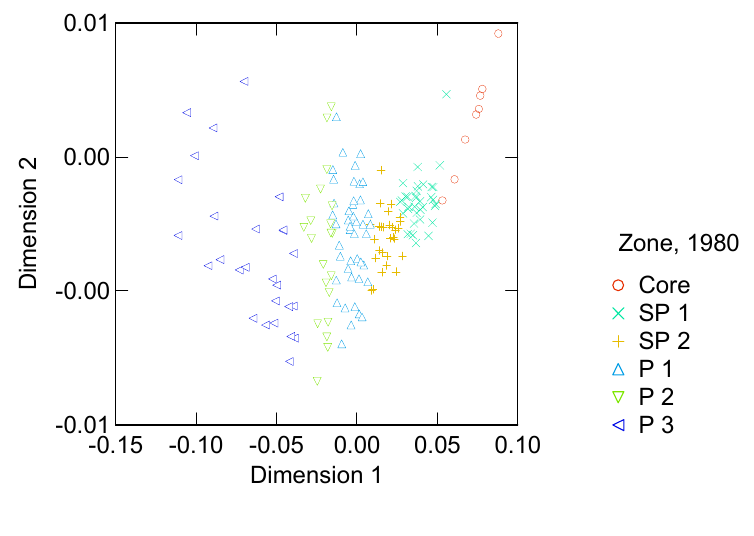
Figure 3: Correspondence Analysis of Regular Equivalence with Hierarchical Clustering Superimposed,